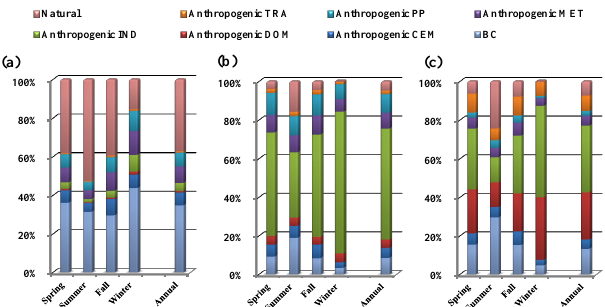
Figure 4. Source contributions to seasonal and annual averaged